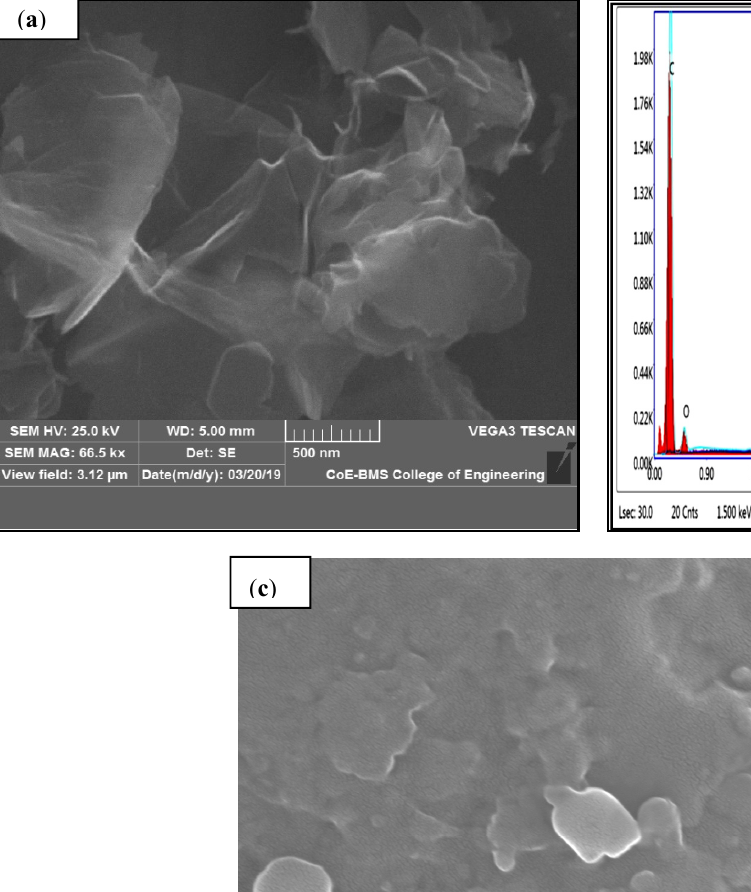
Figure 9. SEM and elemental mapping of ( a , b )PC-ABS, ( c , d )PC-ABS+0.4 wt % graphene, and ( e , f )PC-ABS+0.8 wt % gra- phene.